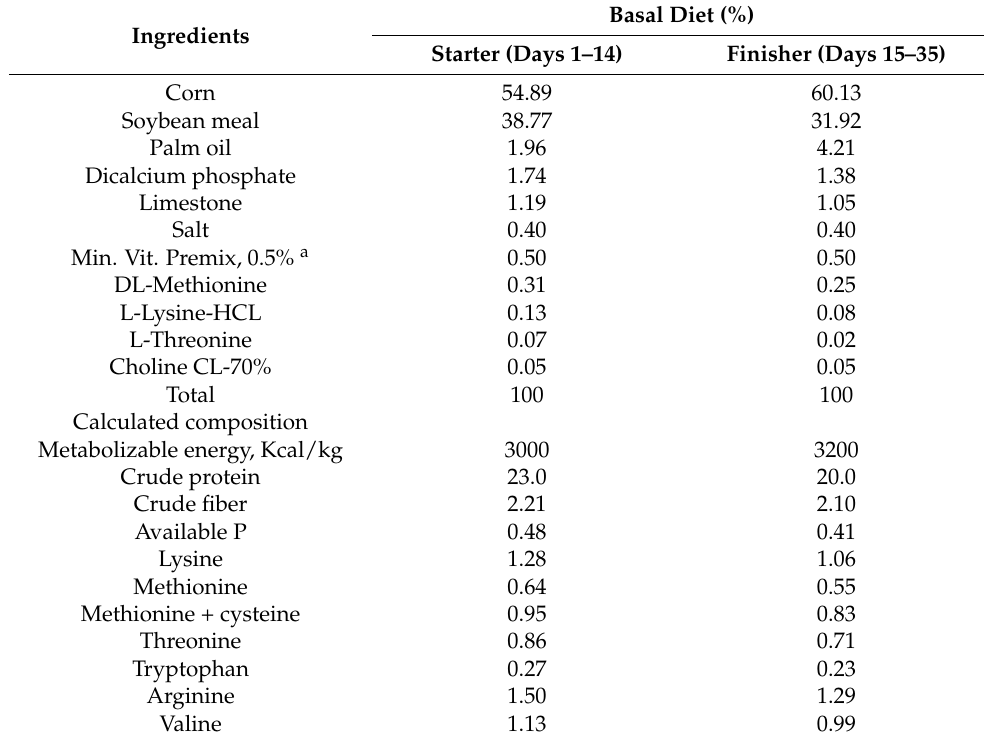
Table 1. Feed ingredients and calculated content of the basal